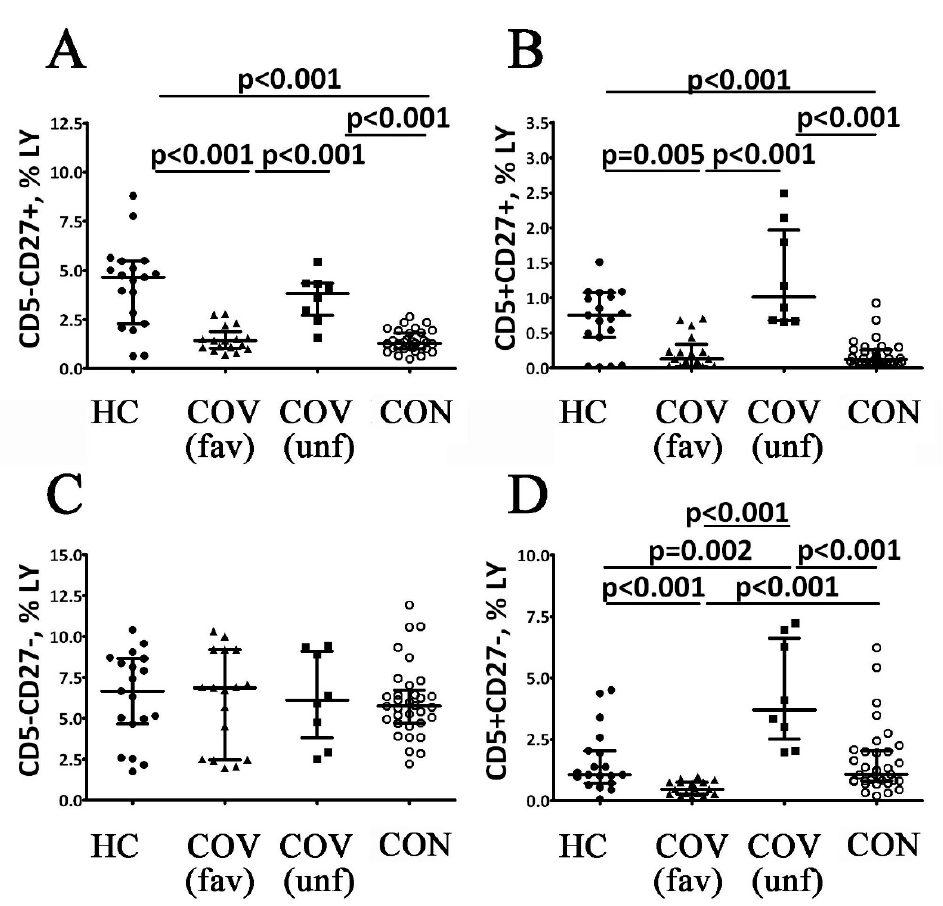
Figure 5. Alterations in relative numbers of B cell subsets with different patters of CD5 and CD27 expression in patients with acute COVID-19 and COVID-19 convalescent patients. Scatter plots ( A – D ) show the percentages of CD5 − CD27 + , CD5 + CD27 + , CD5 − CD27 − and CD5 + CD27 − B cells, respectively. The data represents the percentages of B cell subsets within the total lymphocyte population. Black circles—healthy control (HC, n = 24); black triangles—patients with acute COVID- 19 (COV (fav), favorable outcome, n = 25); black squares—patients with acute COVID-19 (COV (unf), unfavorable outcome, n = 8); and white circles—COVID-19 survivors (CON, convalescent patients with favorable outcome of acute COVID-19, n = 33). Each dot represents individual subjects, and horizontal bars depict the group medians and quartile ranges (Med (Q25; Q75). Statistical analysis was performed with the Mann–Whitney U